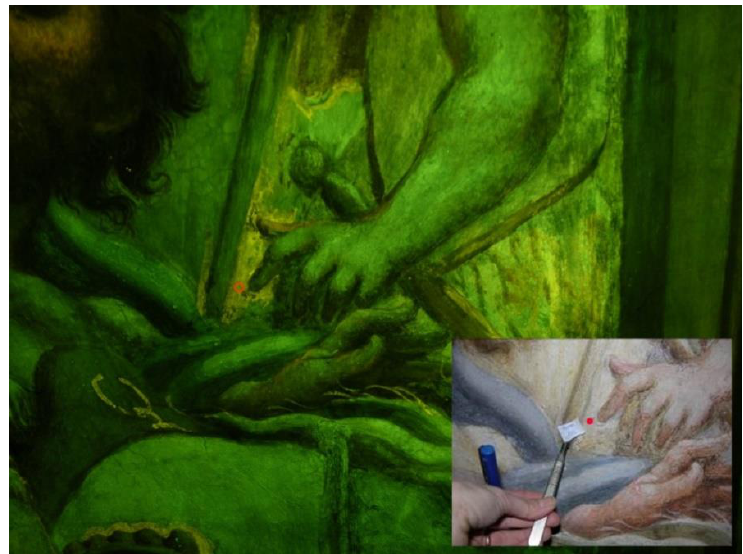
Figure 3. The sampling point for the B20 sample, in normal (red spot in the insert) and in UV light (red circle, main image).